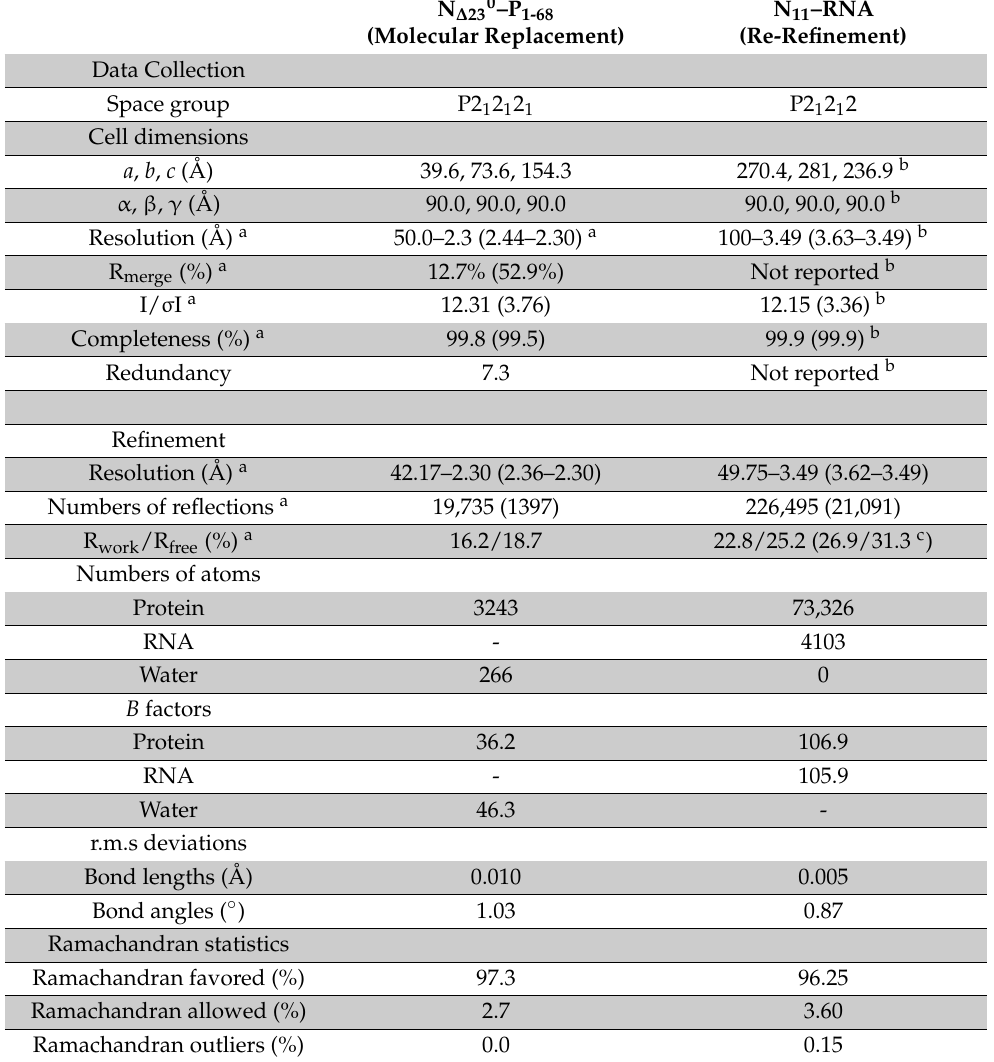
Table 1. Data collection and refinement